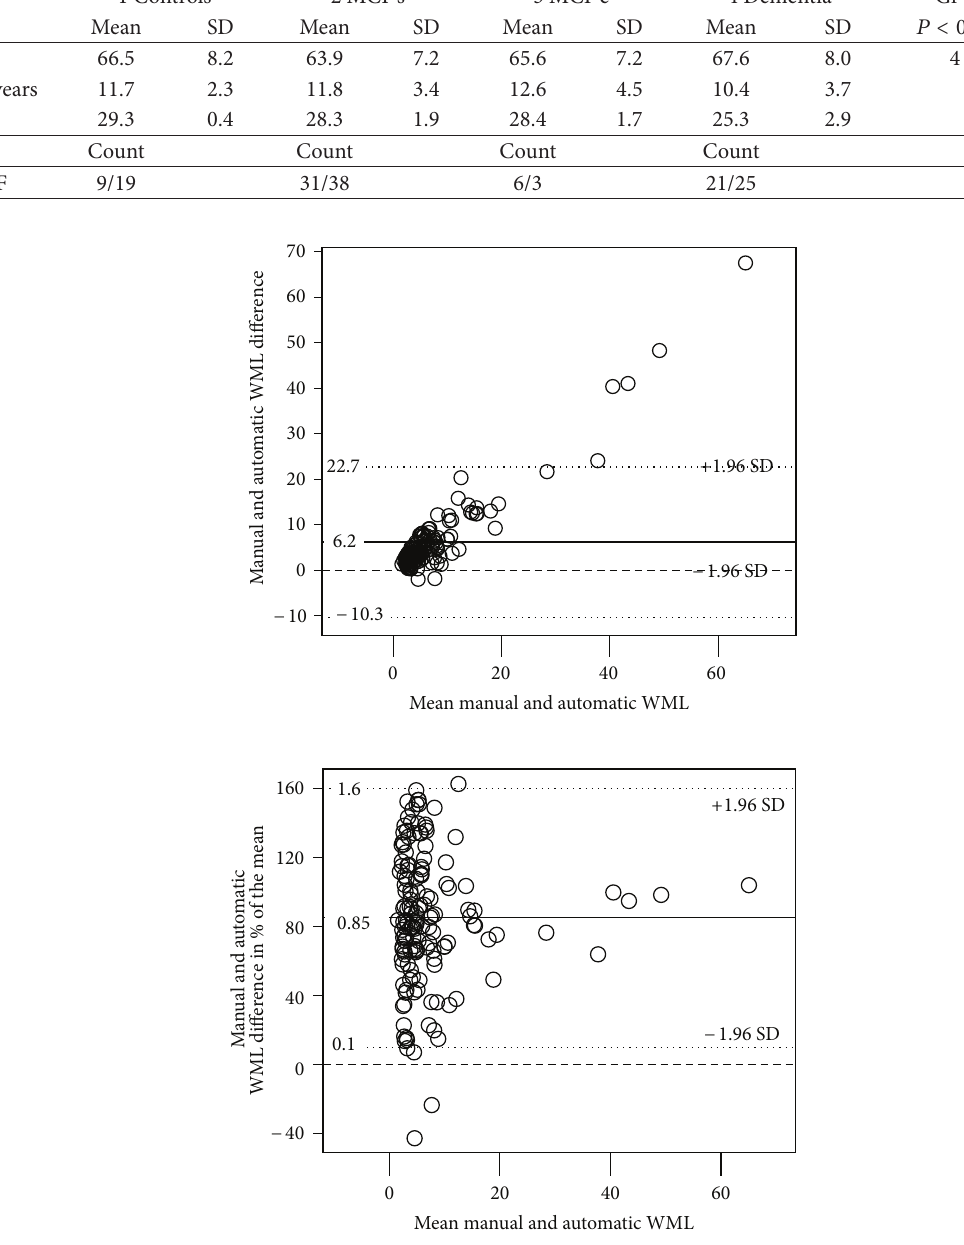
F 1: Bland-Altman plots of the intermethod differences (manual MRIcron minus automatic FreeSurfer WML volumes in cm -axes contain mean WML volumes; the dashed line designates the no differences 𝑥𝑥